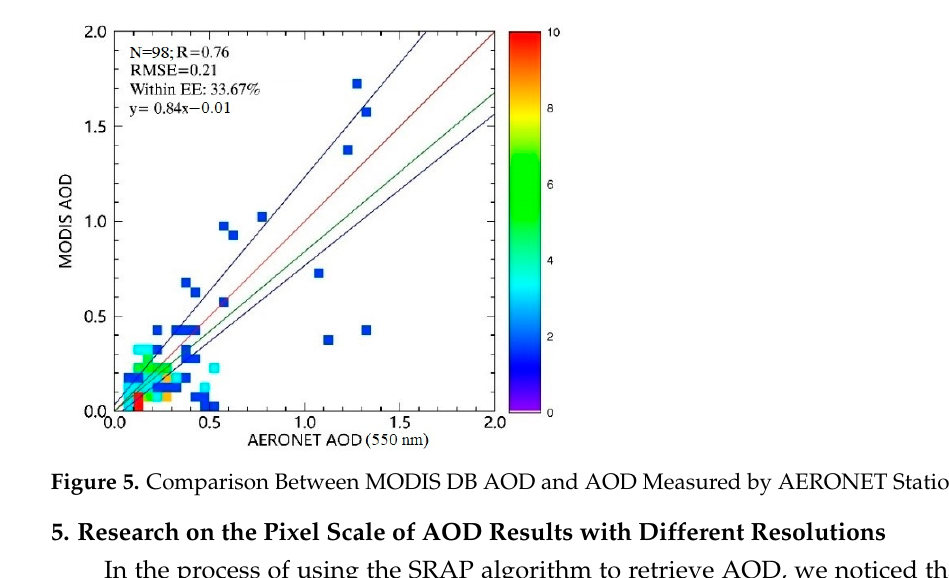
Figure 4. Comparison Between Retrieved AOD Using SRAP Algorithm and AOD Measured by AERONET Stations.